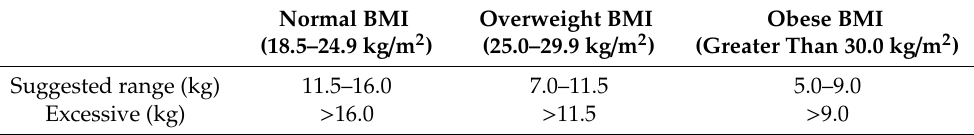
Table 1. Institute of Medicine guidelines for gestational weight gain for singleton pregnancies